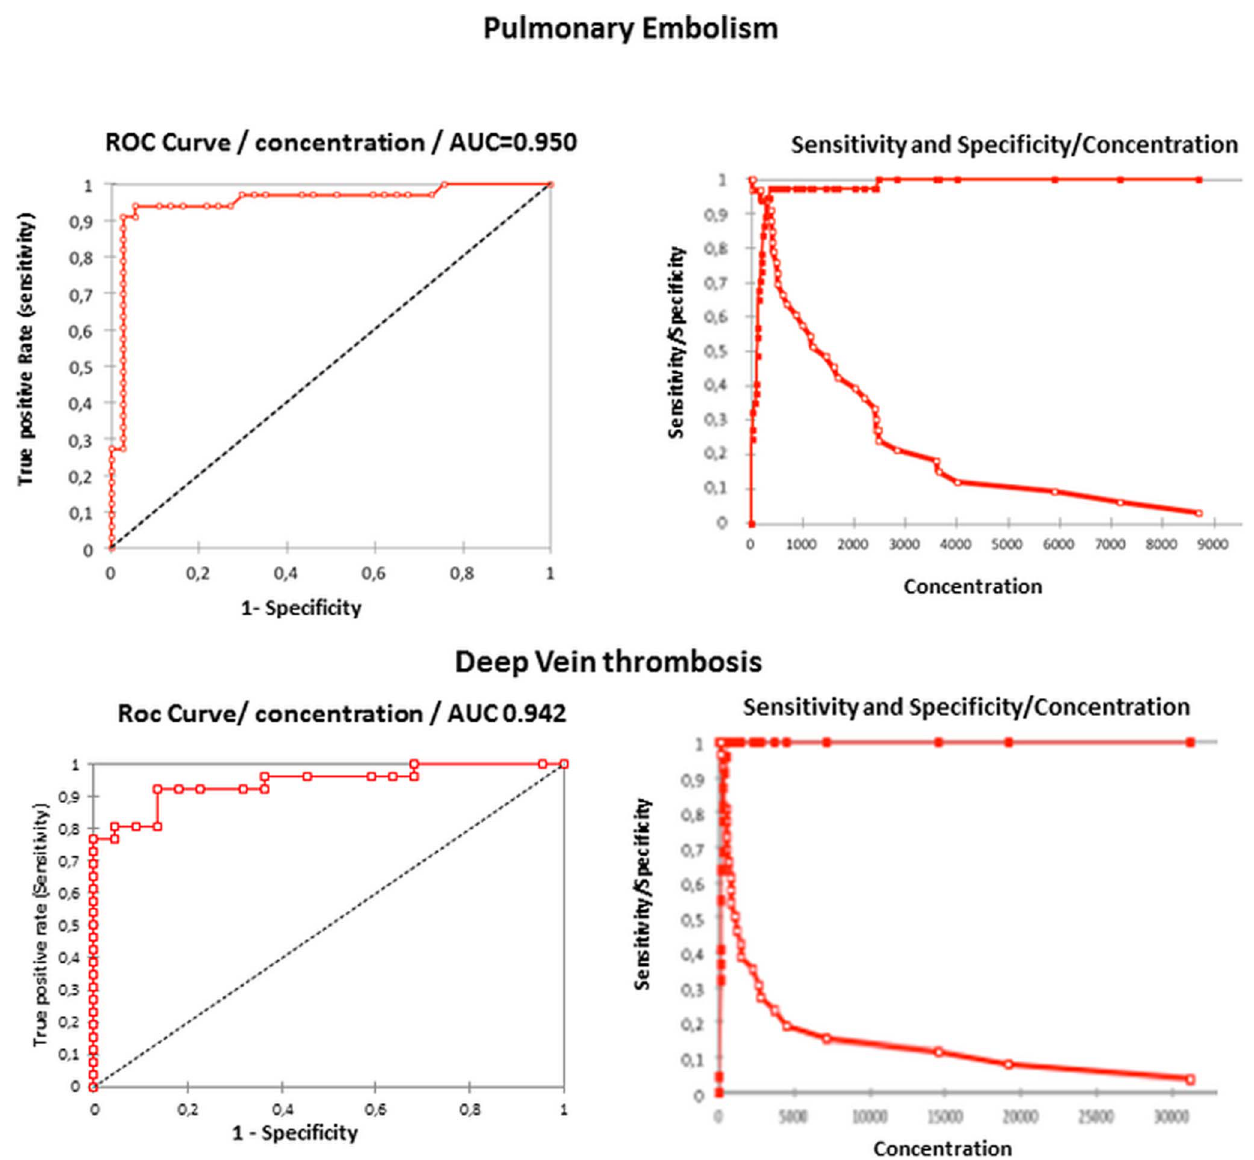
Figure 2. ROC curves for DVT and PE. ROC Curves established for Pulmonary Embolism and for Deep Vein Thrombosis Open squares : Sensitivity Closed square :